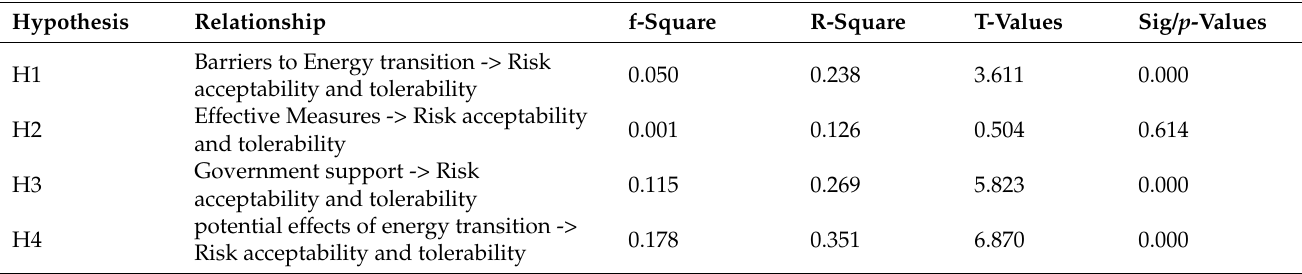
Table 4. Regression